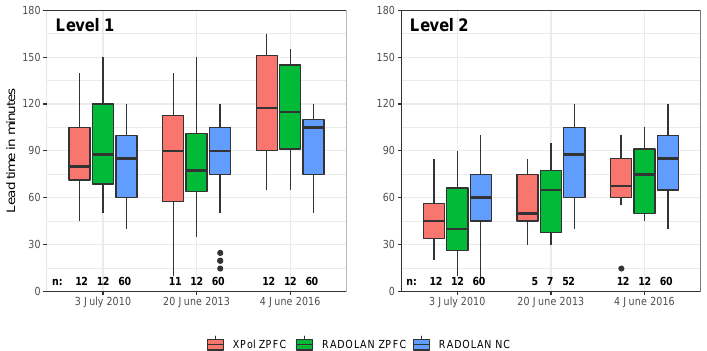
Figure 7. Parflow nowcast experiment lead times, where ZPFC is the zero precipitation forecast and NC the nowcast. The “n” given at the bottom of the plot signifies the number of ensemble members surpassing the respective discharge level and thus being included in the plot out of a potential of 12 (ZPFC) or 60